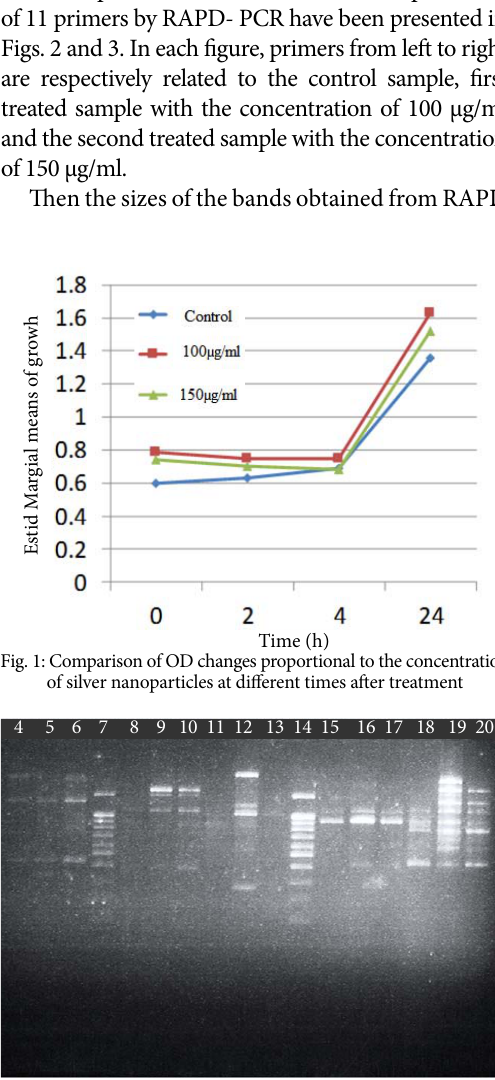
Fig. 2: Image of electrophoresis for PCR products on agarose gel